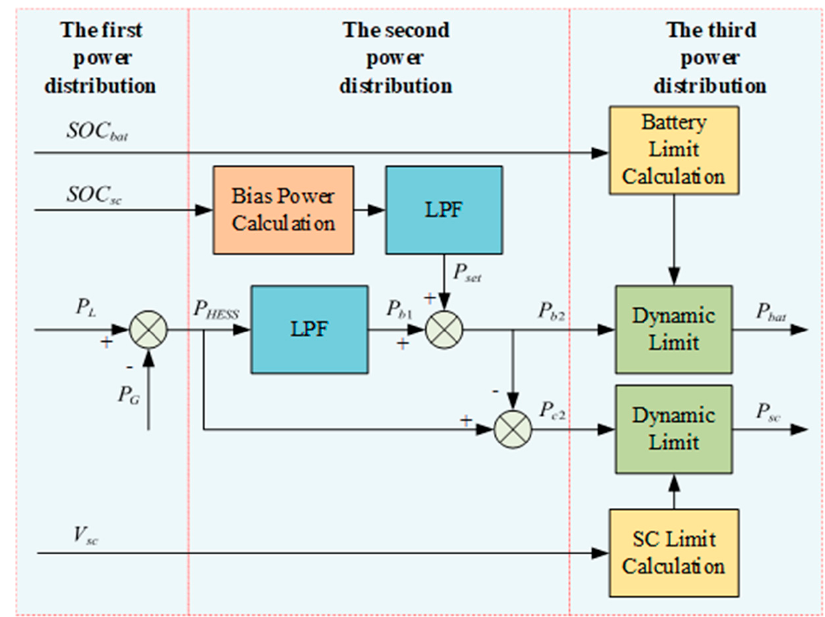
Figure 8. Schematic diagram of TSPD.